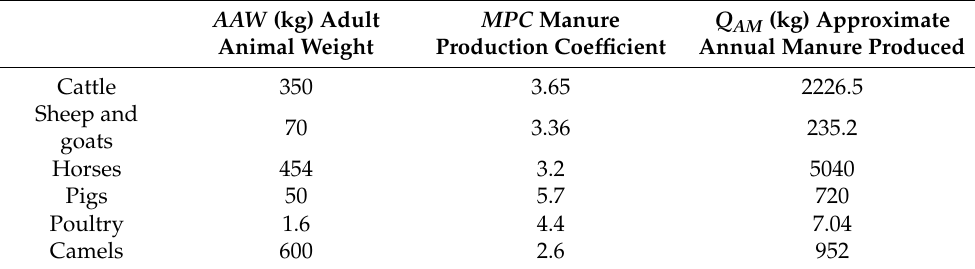
Table 2. Weights and manure production coefficients for different adult animals [41–44].